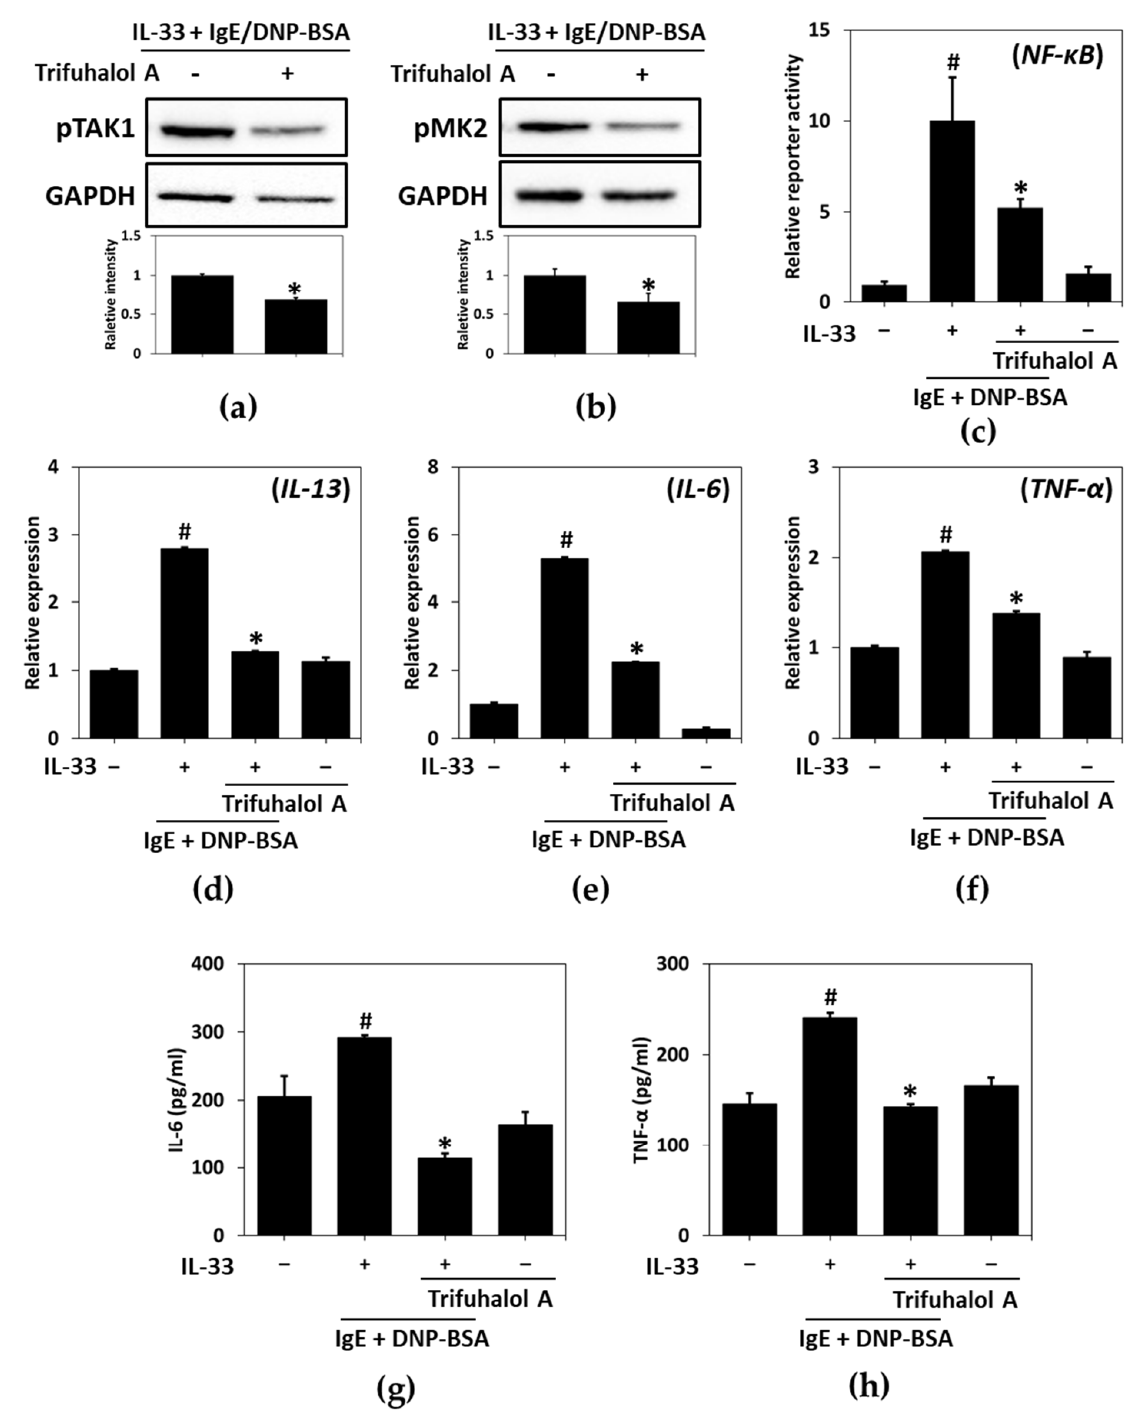
Figure 2. Effects of trifuhalol A on IL-33- and IgE-induced immune activation. Phosphorylation pat- terns of TAK1 ( a ) and MK2 ( b ) in RBL-2H3 cells in response to IL-33 (70 pg/mL) and IgE (50 ng/mL) in the presence or absence of trifuhalol A (100 μ M). * p < 0.05 vs. IL-33 + IgE + DNP-BSA treated group. Each bar represents the mean ± S.D. * p < 0.05 vs. IL-33 + IgE/DNP-BSA-treated group. ( c ) Luciferase assay of NF- κ B transactivation in RBL-2H3 cells treated with IL-33 and IgE in the presence or absence of trifuhalol A (100 μ M). Transcriptional levels of IL-13 ( d ), IL-6 ( e ) and TNF- α ( f ) stimulated by IL-33 and IgE for 4 h in the presence or absence of 100 μ M of trifuhalol A. Translational levels of IL-6 ( g ) and TNF- α ( h ) stimulated by IL-33 and IgE for 4 h in the presence or absence of 100 µ M of trifuhalol A. # p < 0.05 vs. control group; * p < 0.05 vs. IL-33 + IgE + DNP-BSA treated